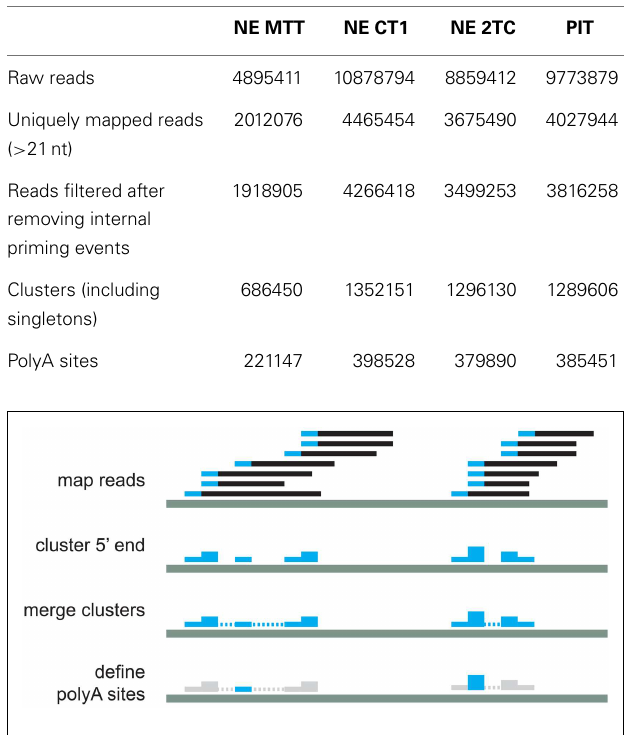
Table 2 | Read processing statistics.